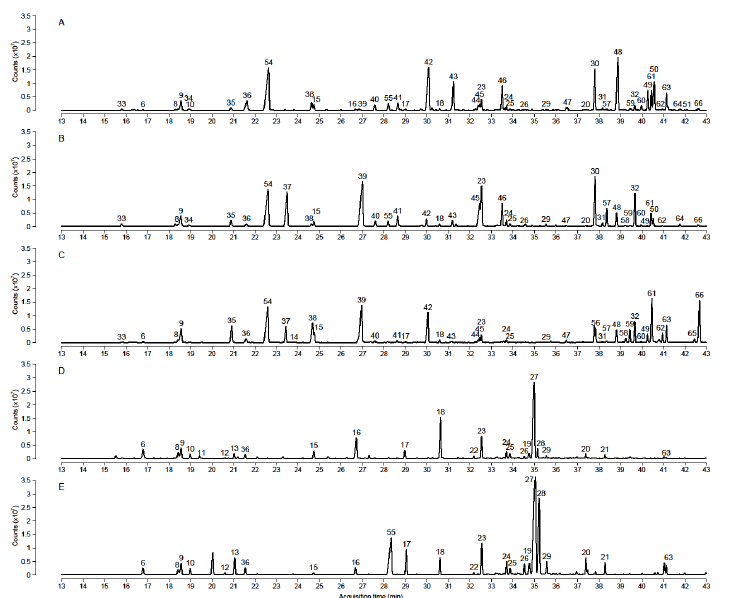
Figure 1. Chromatographic separation was carried out on a DB-5MS column, and the extraction were performed with CAR/PDMS fiber for 65 min at an extraction temperature of 75 °C. ( A ) TIC of orange crocata . ( B ) TIC of yellow crocata . ( C ) TIC of T. caliginosa . ( D ) TIC of LP-xiphi. ( E ) TIC of HP-xiphi. For chromatograms obtained using the first extraction method (low values of temperature and extraction time), see Figure S1 in the Supplementary Material. The identification numbers correspond to those shown in Table 2.